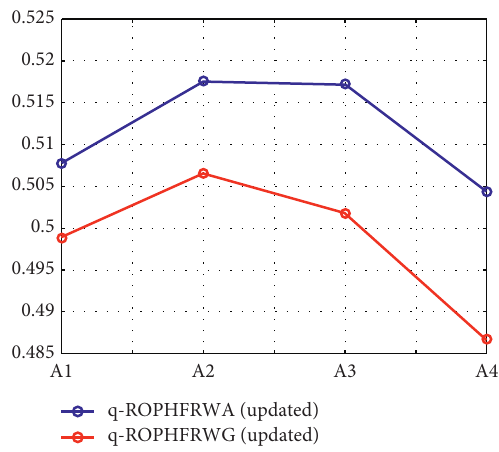
Figure 5: Alternatives using test EWA and EWG